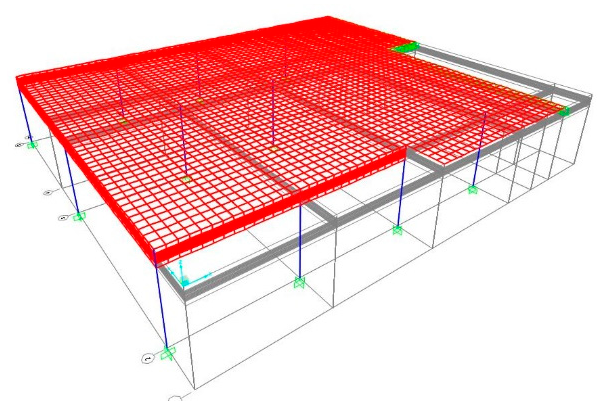
Figure 29. Finite element mesh of the second case of study.